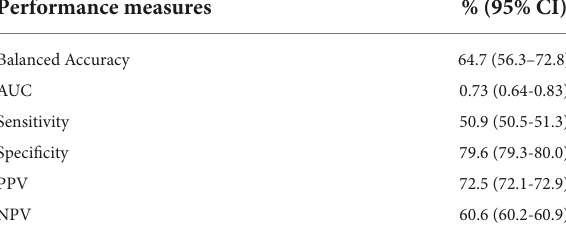
TABLE 4 Final SVM model performance